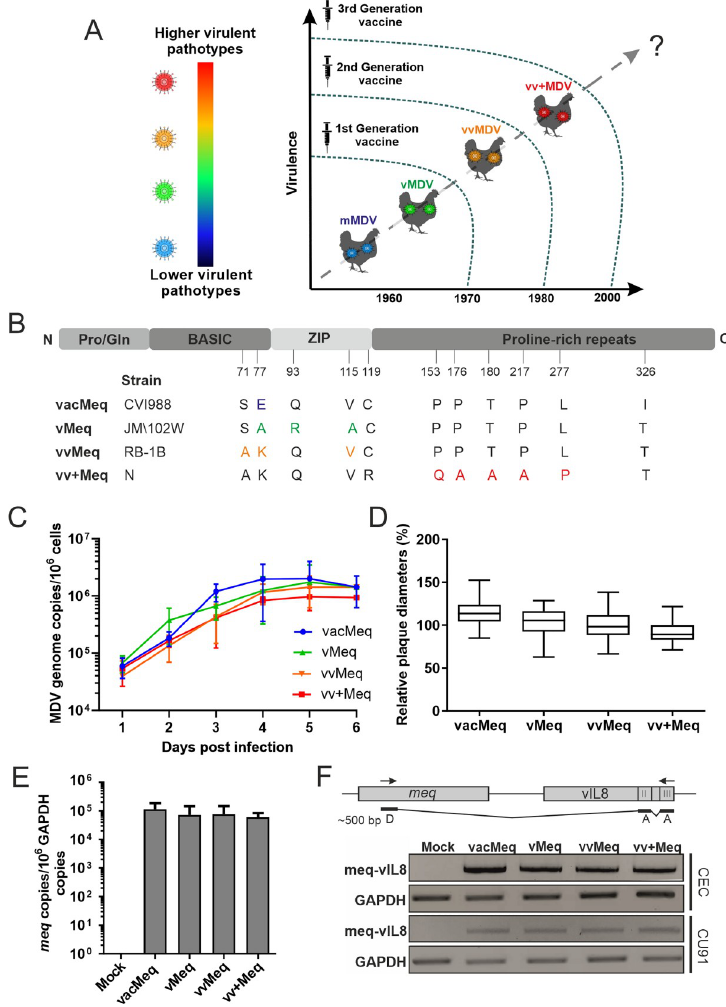
Fig 1. Characterization of the recombinant viruses in vitro . (A) A schematic illustration of the evolution of MDV towards increased virulence in the context of the indicated vaccine generations. (B) The representation of the Meq protein with its domains. The N-terminal region comprises of a proline/glutamine (Pro/Gln) rich domain followed by the basic region and the leucine zipper (ZIP). (C) Virus replication was assessed by multi-step growth kinetics. Mean viral genome copies per one million cells are shown for the indicated viruses and time points (p > 0.05, Kruskal–Wallis test, n = 3). (D) Plaque size assays of indicated recombinant viruses. The mean plaque diameters of three independent experiments are shown as box plots with minimums and maximums (p > 0.05, one-way ANOVA, n = 150). (E) The meq expression levels in infected CEC were assessed by RT-qPCR. Meq expression is shown relative to one million copies of the cellular glyceraldehyde-3-phosphate dehydrogenase (GAPDH) and were not statistically different (Kruskal-Wallis test). (F) RT-PCR analysis of the meq /vIL8 splice variant using primers specific for the donor site “D” in meq and the acceptor sites “A” in vIL8. GAPDH was used as a